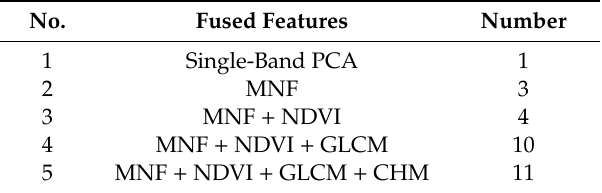
Table 3. Di ff erent feature fusion methods and numbers for ground object classification.